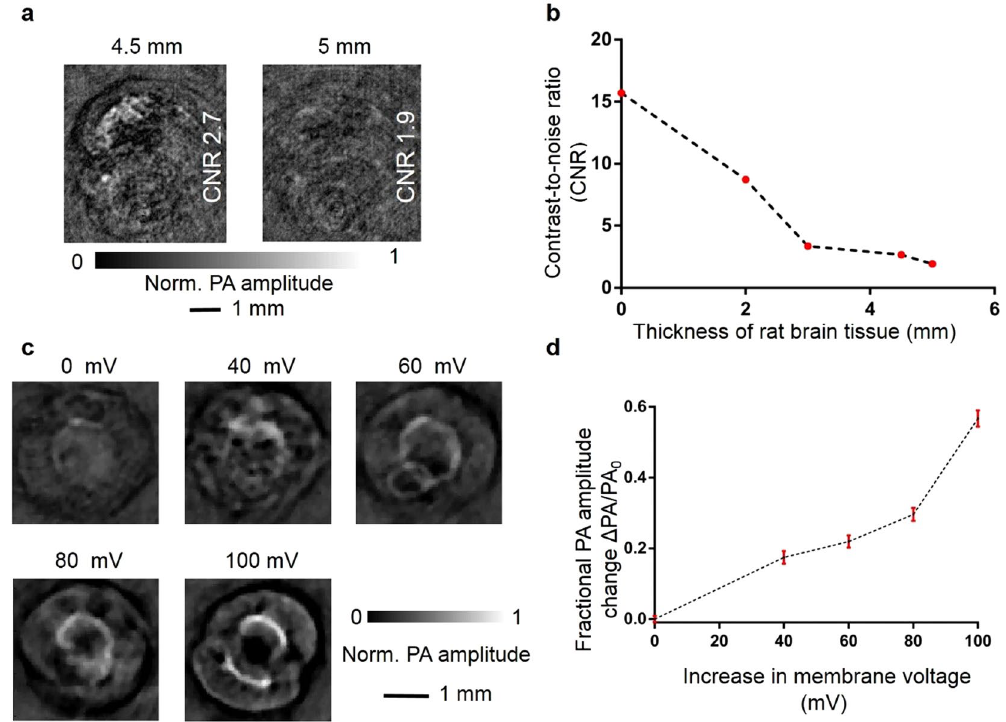
Figure 4. Imaging HEK-293 cell clusters with different resting potentials through different thicknesses of ex vivo brain tissue. ( a ) HEK-293 cell cluster PACT images through 4.5 mm and 5.0 mm thick brain tissue. ( b ) The contrast-to-noise ratios of the HEK-293 cell cluster images acquired through 0.0 mm, 2.0 mm, 3.0 mm, 4.5 mm, and 5.0 mm thick brain tissue decrease as the brain tissue thickness increases. ( c ) Photoacoustic images of HEK- 293 cell clusters acquired through 4.5 mm thick brain tissue in response to cell membrane voltage changes. ( d ) Fractional photoacoustic signal change versus cell membrane voltage